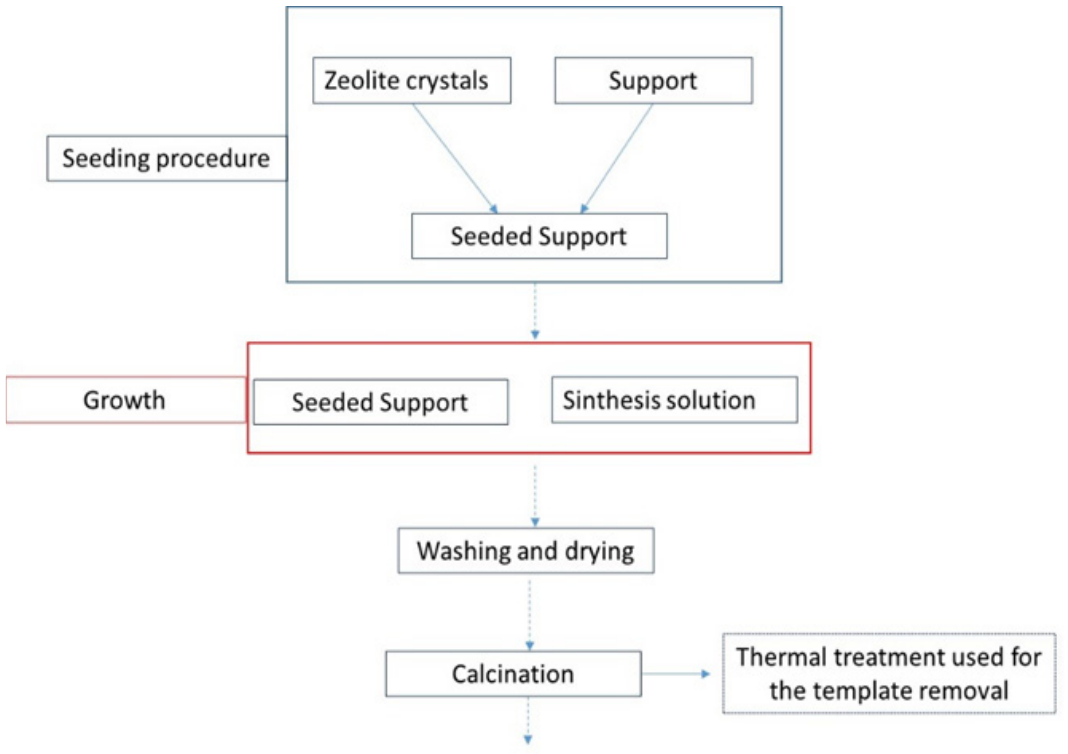
Figure 2. Scheme of the secondary growth method.